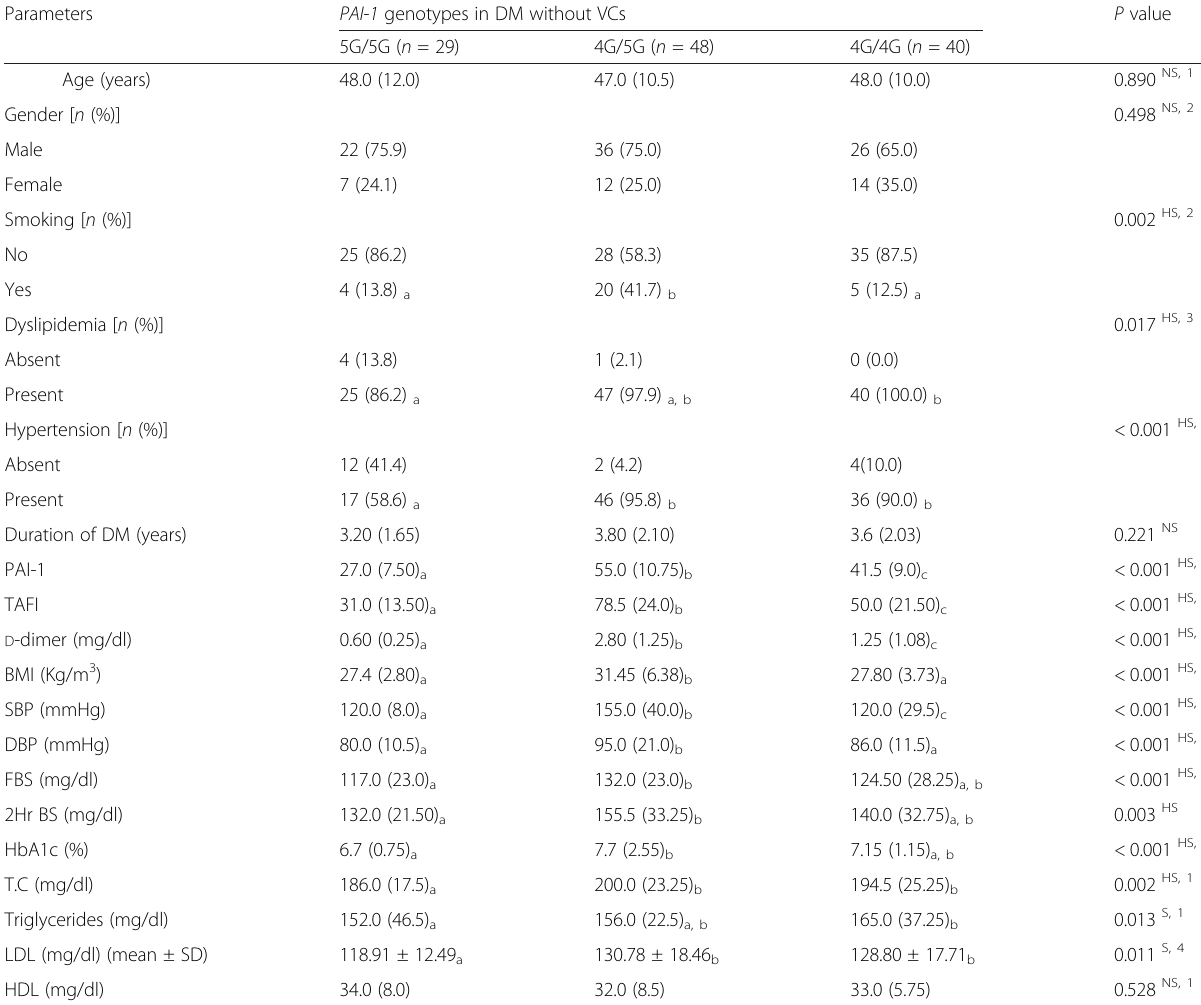
Table 3 Comparison between PAI-1 genotypes regarding demographic and clinical data in diabetes without vascular complication